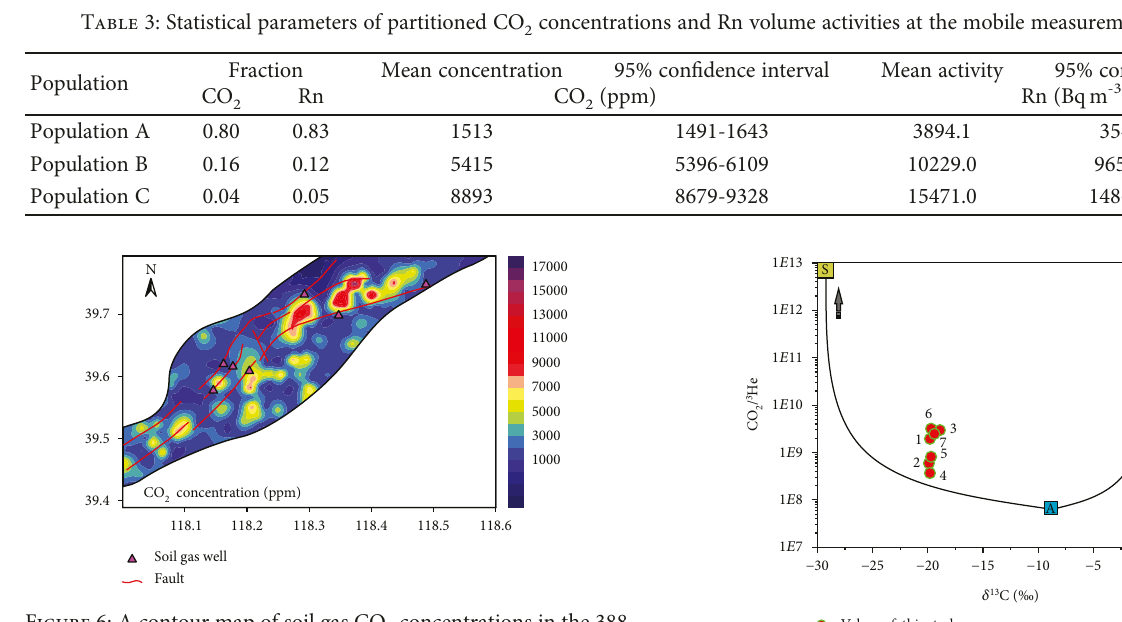
contributions by di ff erent end-members to 2